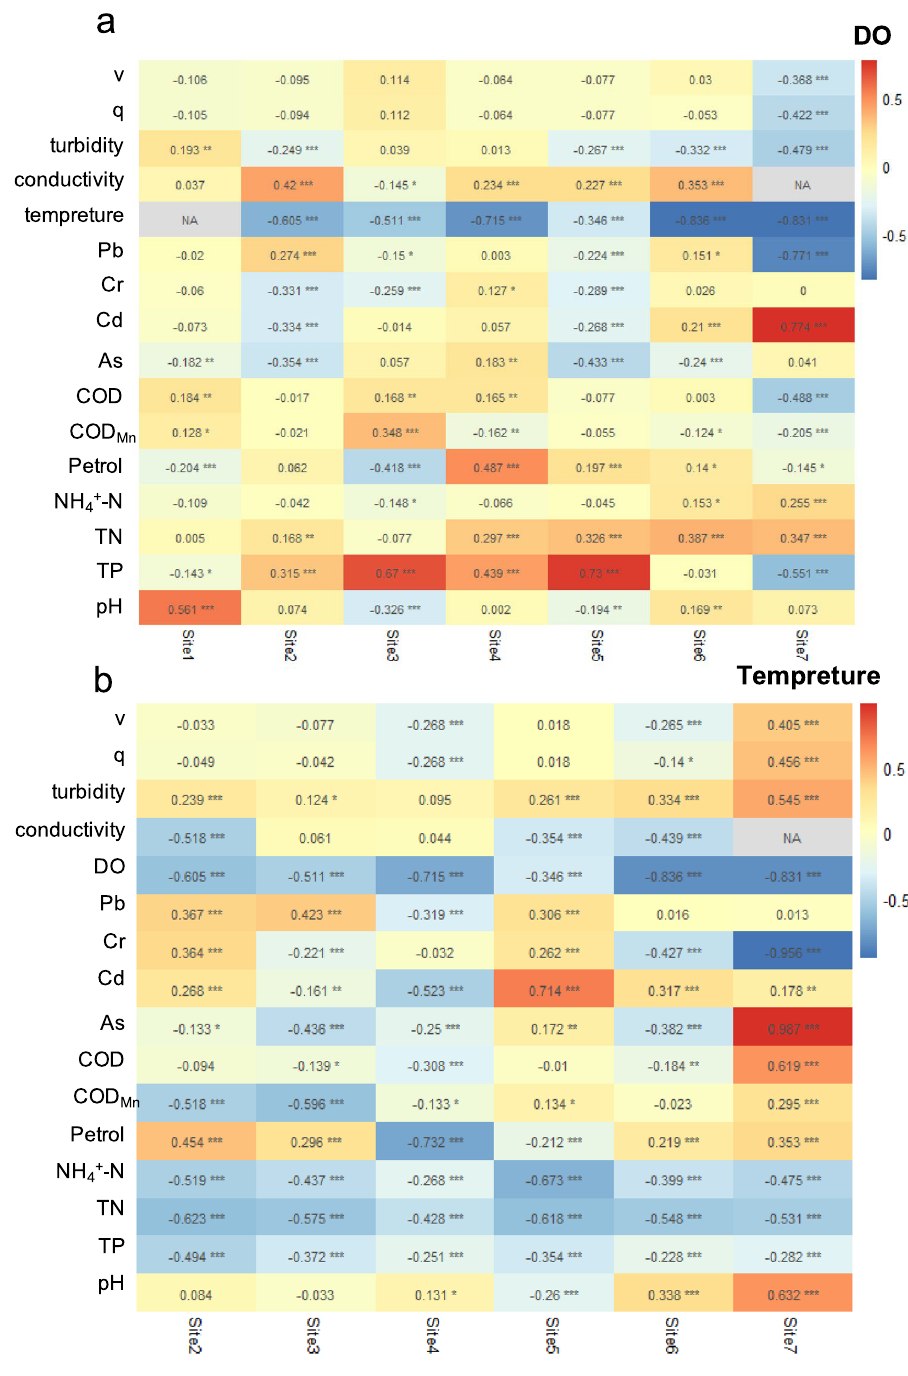
Figure 3. Heatmap for Pearson correlations between water quality parameters and ( a ) DO or ( b ) water temperature at seven on-line monitoring stations, respectively. Velocity, flow velocity; Q, flow; Turbidity, water turbidity; Conductivity, water conductivity; DO, dissolved oxygen; Temperature, water temperature; COD, chemical oxygen demand; COD Mn , chemical oxygen demand indicated by Permanganate Index; NH 4+ -N, ammonium; TN, total nitrogen; TP, total phosphorus; pH, water pH. Water temperature at site 1 and water conductivity at site 7 were